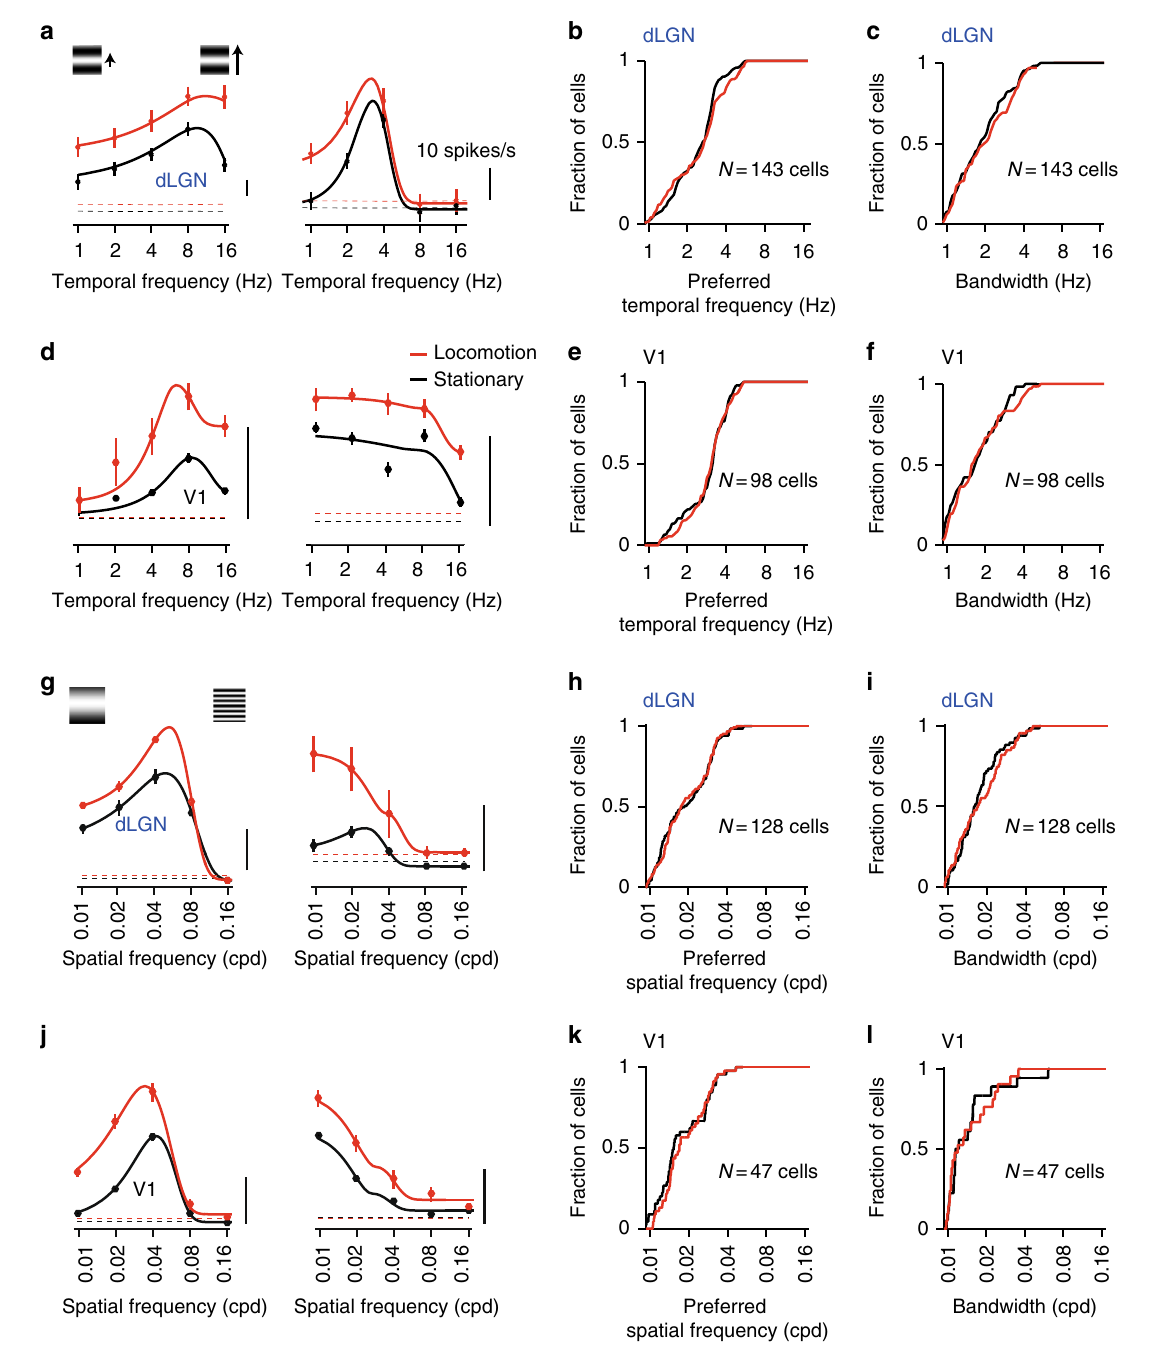
Fig. 6 Unspeci fi c impact on spatial and temporal frequency tunings. a Temporal frequency tuning of F1 responses of example dLGN cells in ocomotion (red) and stationary (black) epochs. Scale bar, 10 spikes/s. b Distribution of preferred temporal frequency of dLGN neurons ( N = 143 cells) estimated from locomotion (red) and stationary (black) trials. c Distributions of temporal frequency bandwidth for the cells in b . d Temporal frequency tuning curves of F1 responses of example V1 cells estimated from locomotion (red) and stationary (black) trials. e Distributions of preferred temporal frequency of V1 neurons (N = 98 cells) in locomotion (red) and stationary (black) trials. f Distributions of temporal frequency bandwidth for cells in e . g Example spatial frequency tuning curves of dLGN cells. h Distributions of preferred spatial frequency of dLGN neurons (N = 128 cells). i Distibutions of spatial frequency bandwidth for cells in h . j Example spatial frequency tuning curves of V1 cells. k Distributions of preferred spatial frequency of V1 cells (N = 47 cells). l Distributions of spatial frequency bandwidth for the cells in k . Dashed lines in d, g and j denote F1 responses to gray screen. Continuous lines in a denote F1 of shuf fl ed spike